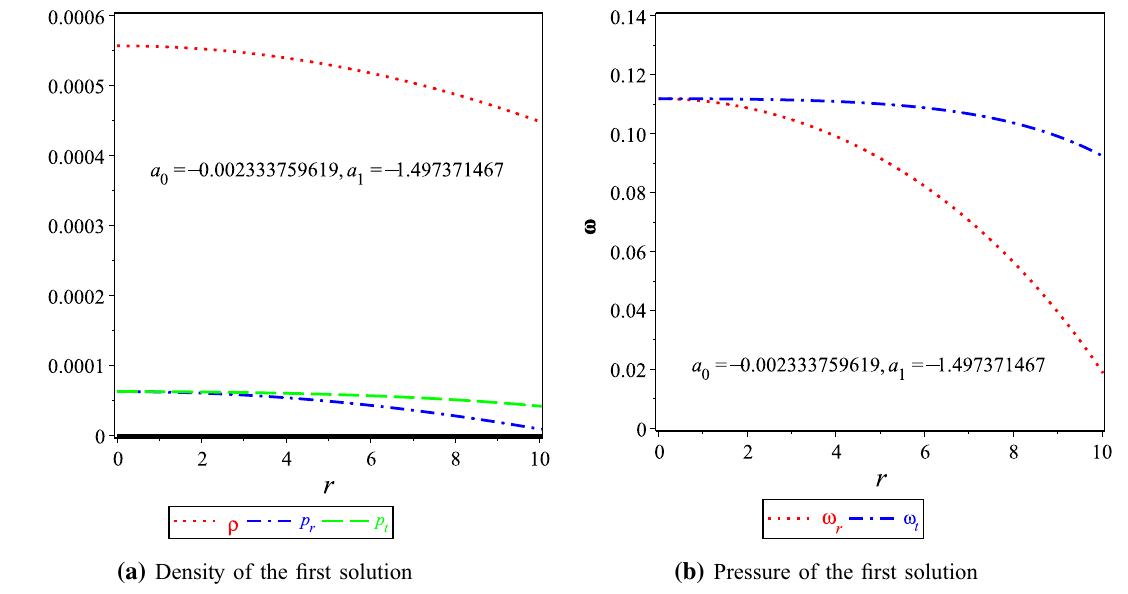
Fig. 10 Schematic plot of the radial coordinate r in the unit of km versus: a the energy density, (a)of solution (42), b the EoS (43) which shows a physical content of matter for the stellar 4U1608–52 whose mass 1 . 74 ± 0 . 14 and its radius 9 . 52 ± 0 . 15